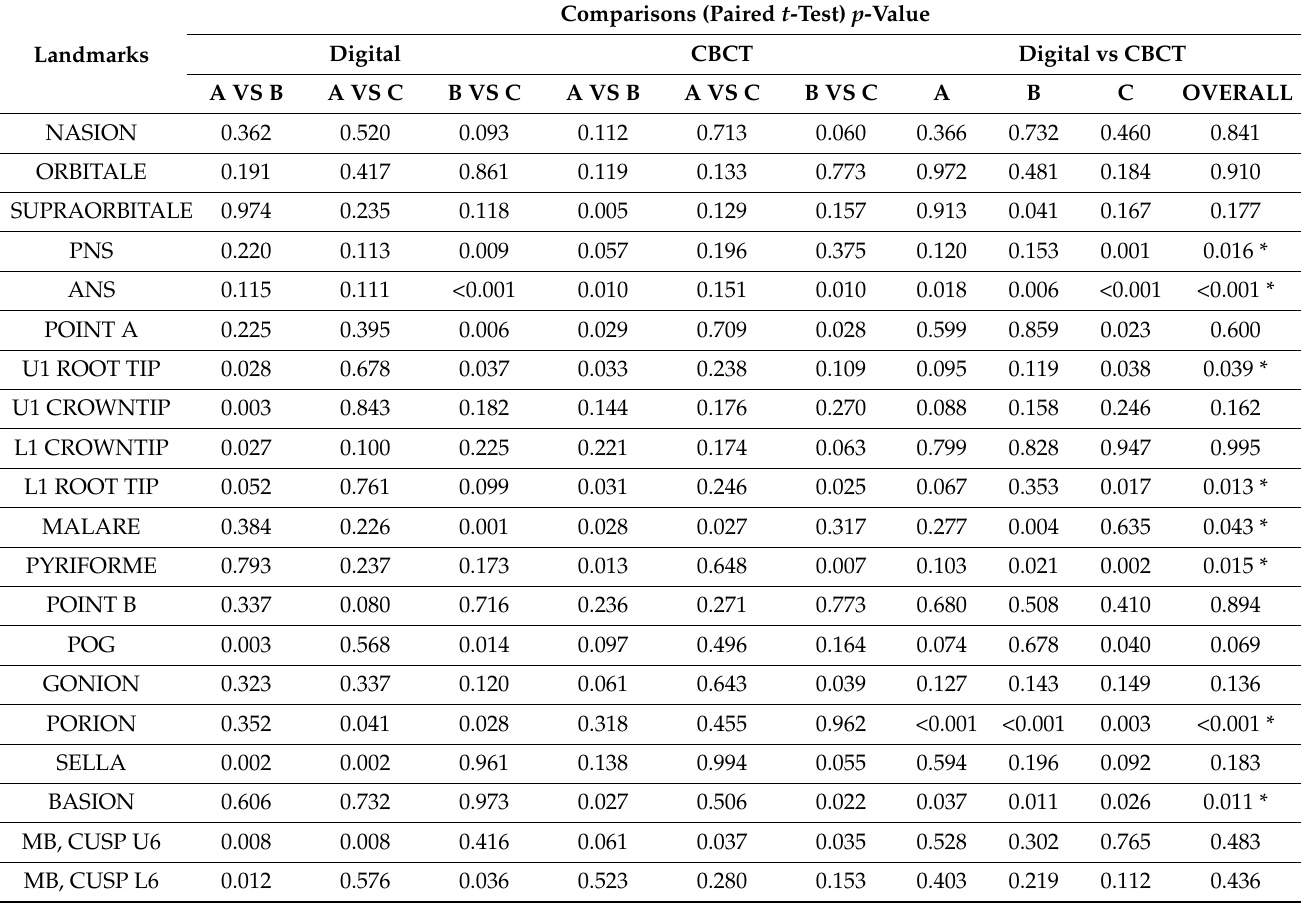
Table 4. Comparison of observations obtained by different observers for digital and CBCT derived cephalograms using t test.